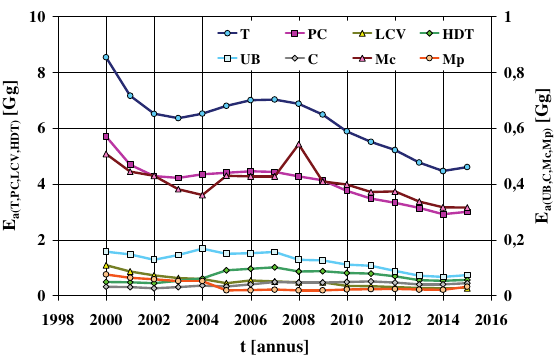
Fig. 11. National annual emission of non-methane volatile organic compounds per cumulated vehicle category